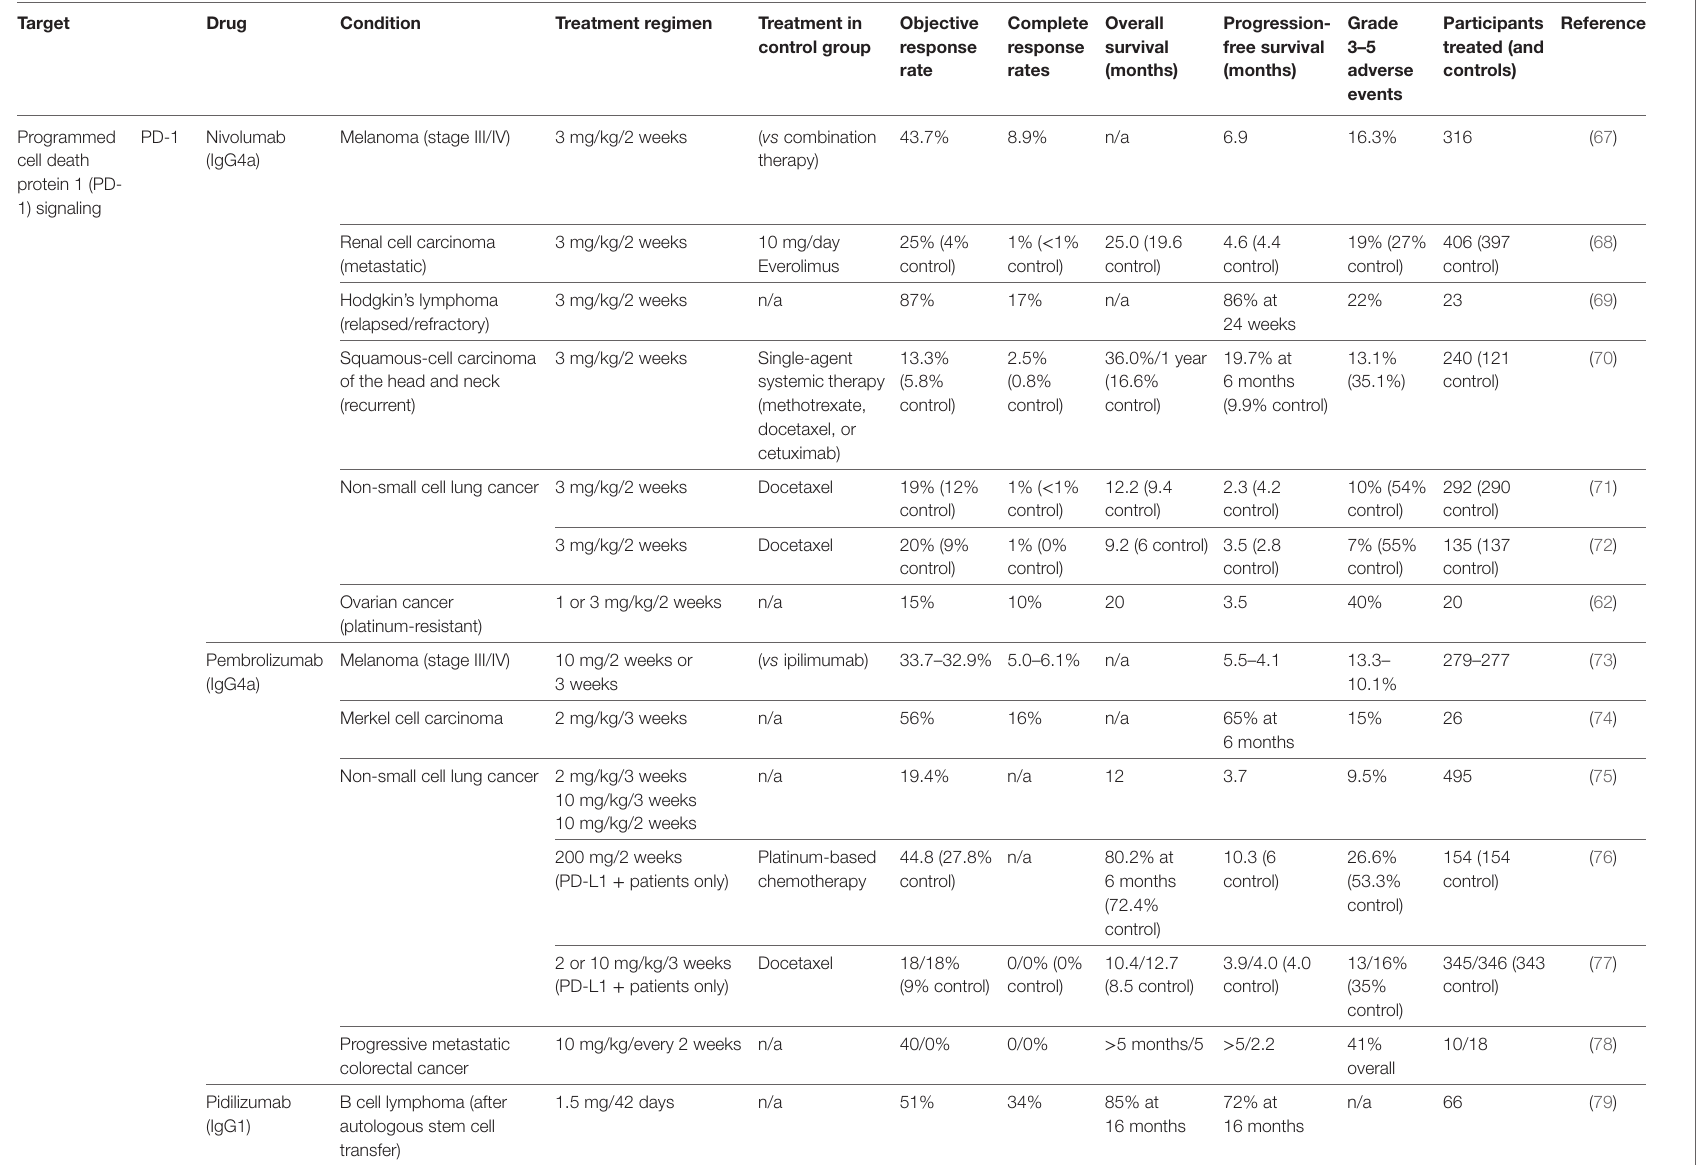
TAbLe 2 | Treatment outcome of clinical trials for immune checkpoint inhibitors in various cancer